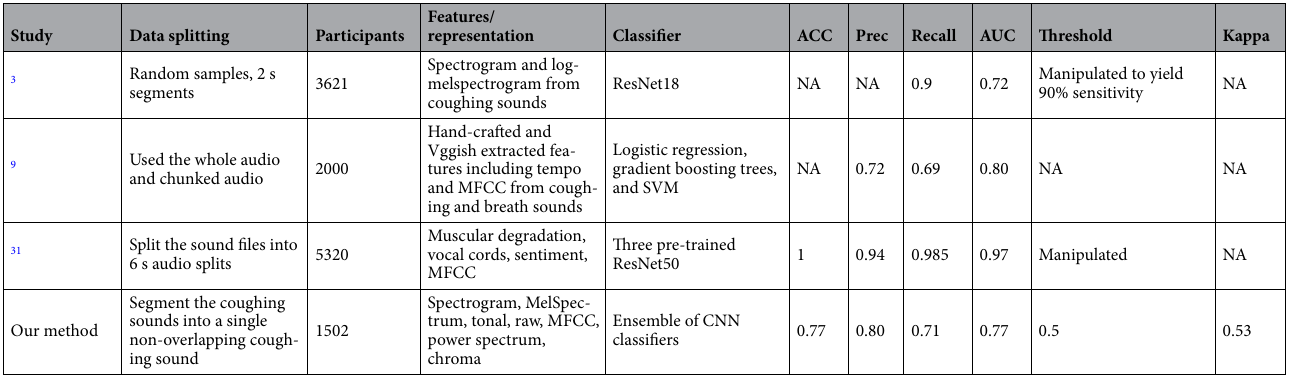
Table 12. Comparison of the model developed in this work with other related works. This comparison is not intended to be a head-to-head comparison because several implementation details are not available.